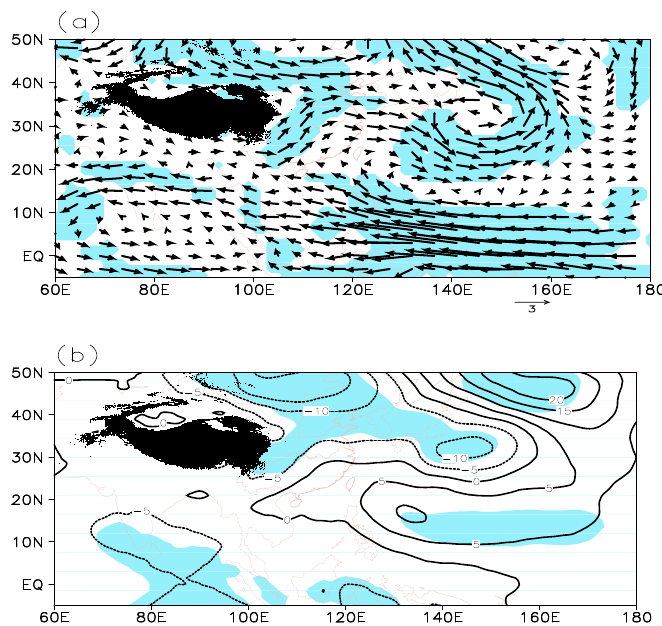
Figure 6. The difference of the composites of ( a ) 700 hPa wind (unit: m s − 1 ) and ( b ) 850 hPa geopotential height (unit: gpm) between wet summers and drought summers in the Sichuan Basin. The blue shadow indicates passing the 95% confidence level, and the black shadow indicates the Tibet Plateau